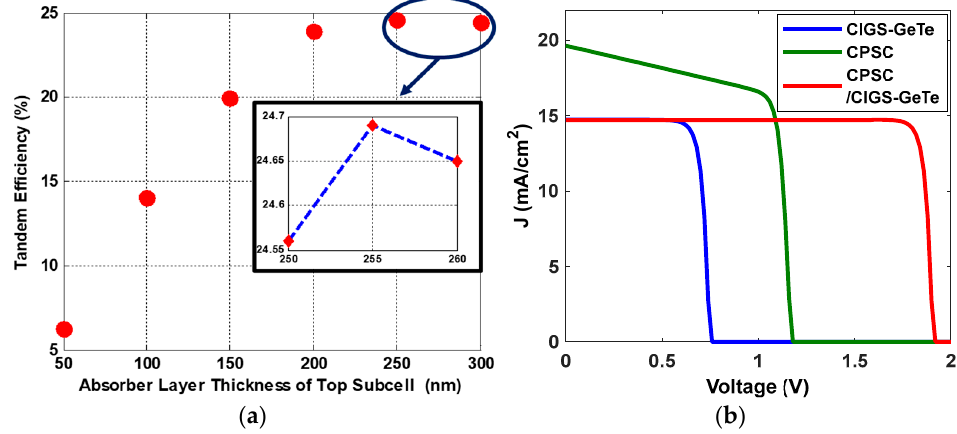
Figure 8. ( a ) PCE of CPSC/CIGS-GeTe tandem solar cell with the thickness of the top cell’s absorber,